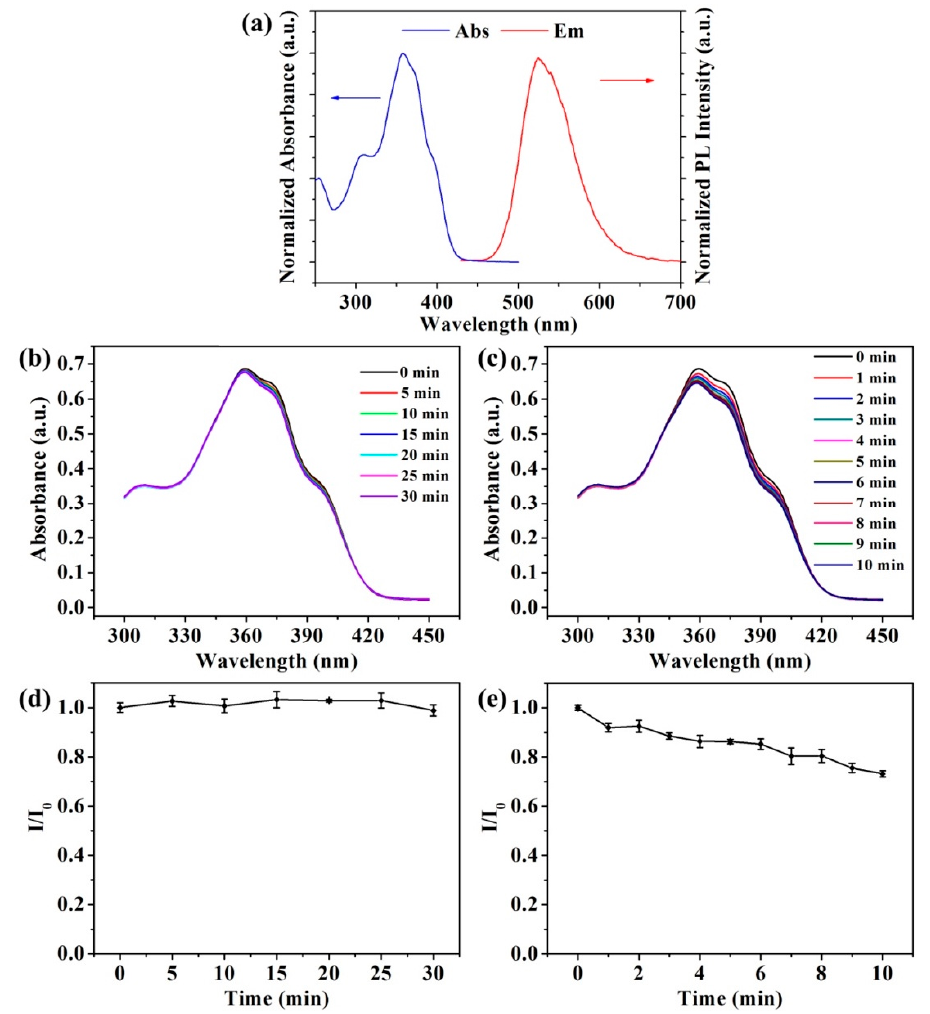
Figure 3. ( a ) Normalized ultraviolet-visible absorbance (blue) and PL (red) spectra of 20 μ M AIE-M in water. The absorption spectra of AIE-M ( b , c ) and plots of I / I 0 ( d , e ) upon continuous irradiation with 365 nm light at 1 mW cm − 2 ( b , d ) or 10 mW cm − 2 ( c , e ). I 0 is the initial FL intensity of AIE-M, and I is the FL intensity of the sample after continuous irradiation for various time intervals.